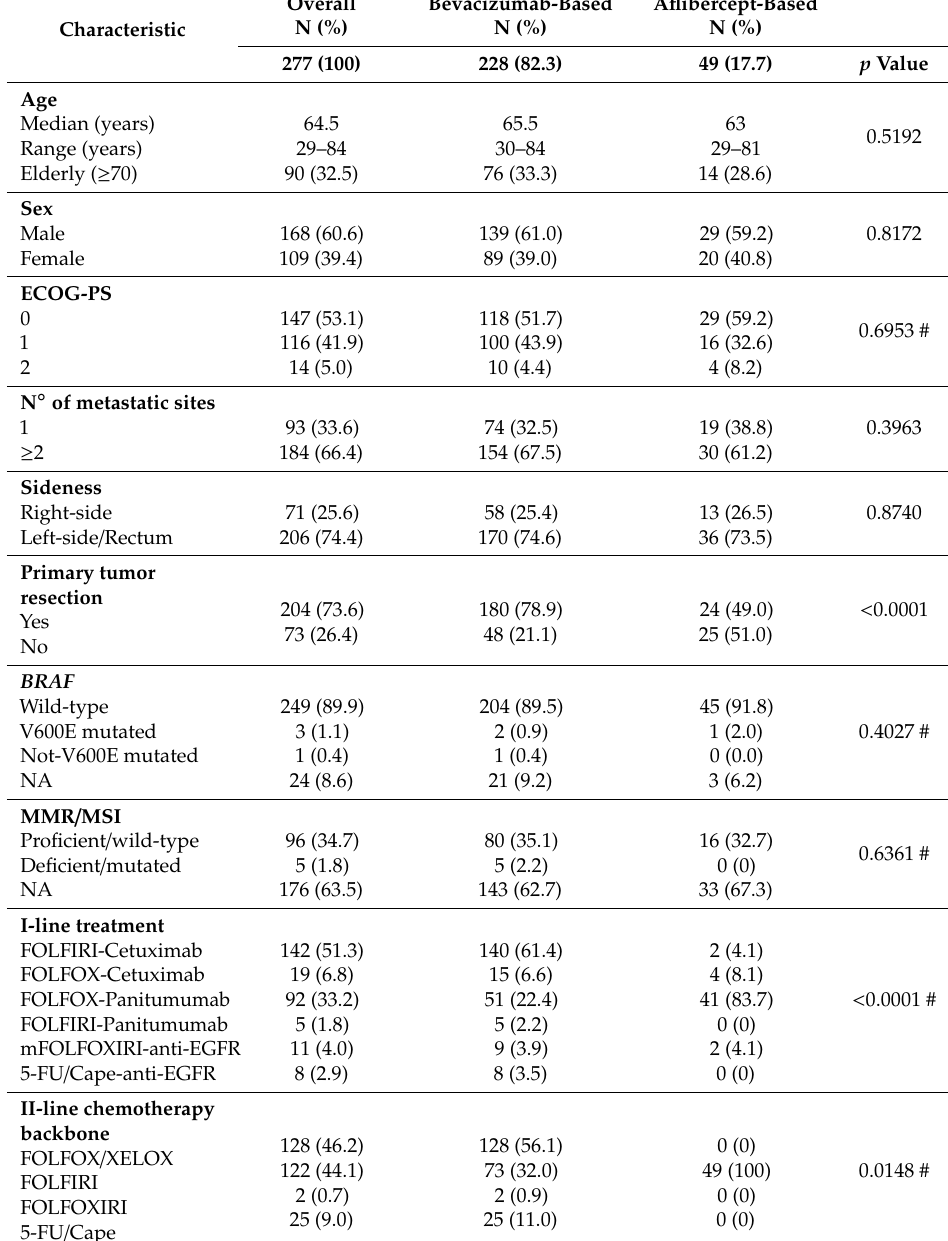
Table 1. Patient and tumor characteristics in overall, Bevacizumab-based, and Aflibercept-based